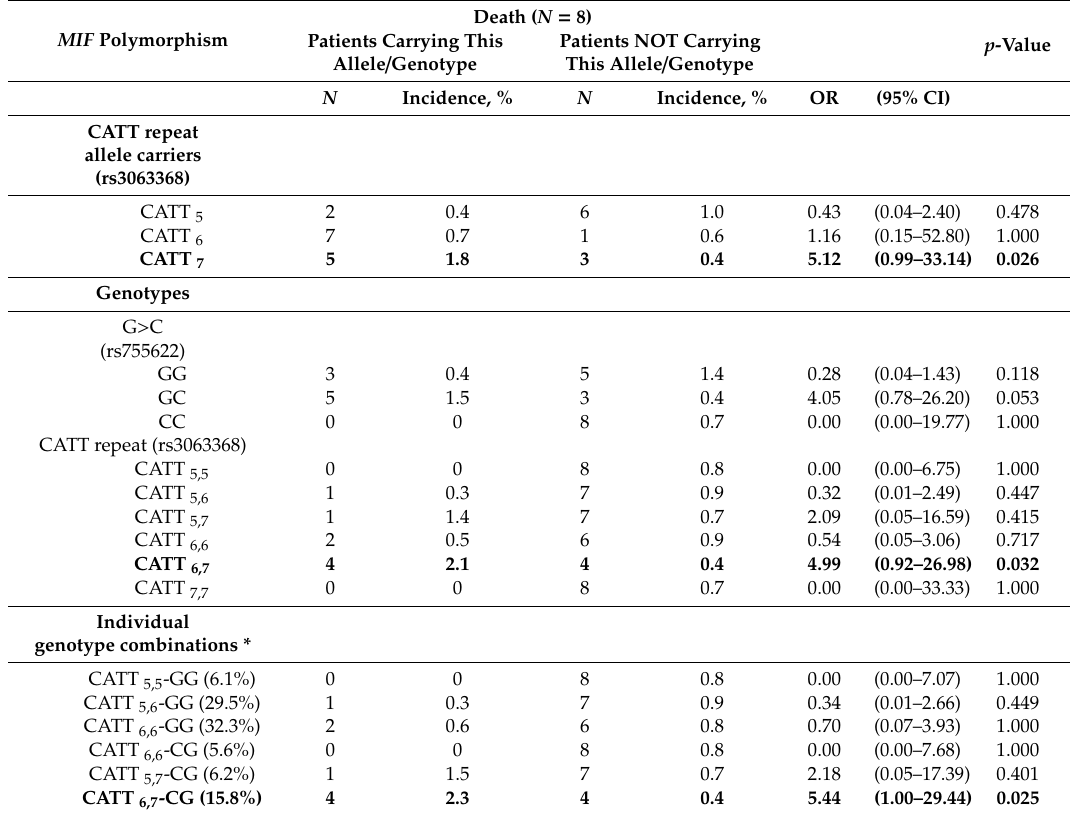
Table 6. Association of the MIF promoter polymorphisms with